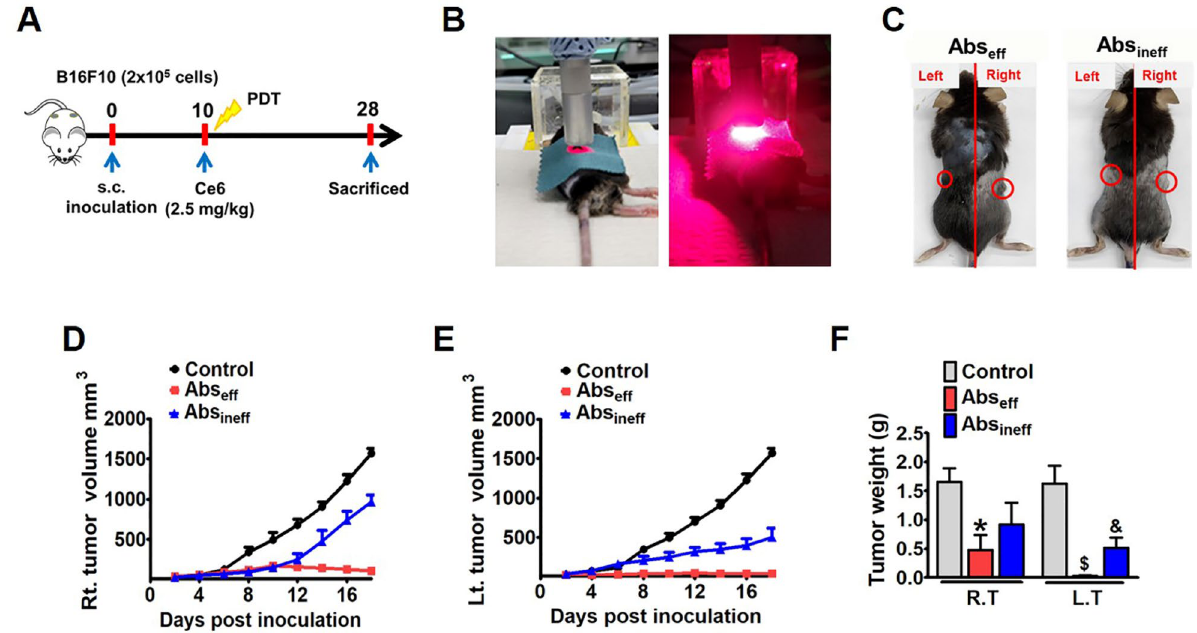
Figure 1. Abscopal antitumor effects in the melanoma mouse model. ( A ) Experimental scheme, ( B ) C57BL/6 mice were inoculated with B16F10 cells, received an intravenous injection of Ce6 (2.5 mg/kg) followed by irradiation using a diode laser (λ = 660 nm) at a rate of 100 J/cm 2 for 8 min 20 s. ( C ) Mice were divided into Abs eff and Abs ineff groups on the basis of the abscopal effect with Ce6-PDT. ( D ) Right tumor (RT) volume, ( E ) left tumor (LT) volume, ( F ) right and left tumor weight in the control, Abs eff and Abs ineff groups respectively. Data are from an experiment representative with n = 3 in the control, n = 3 in the effective, and n = 4 in the ineffective group. * P < 0.05 compared to right control tumor. # P < 0.05 compared to right tumor of